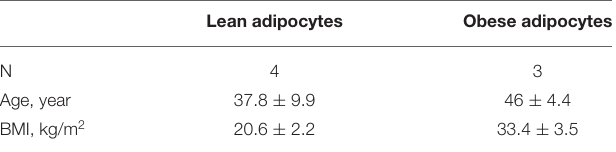
TABLE 1 | Data of adipocytes from lean and obese subjects. Lean